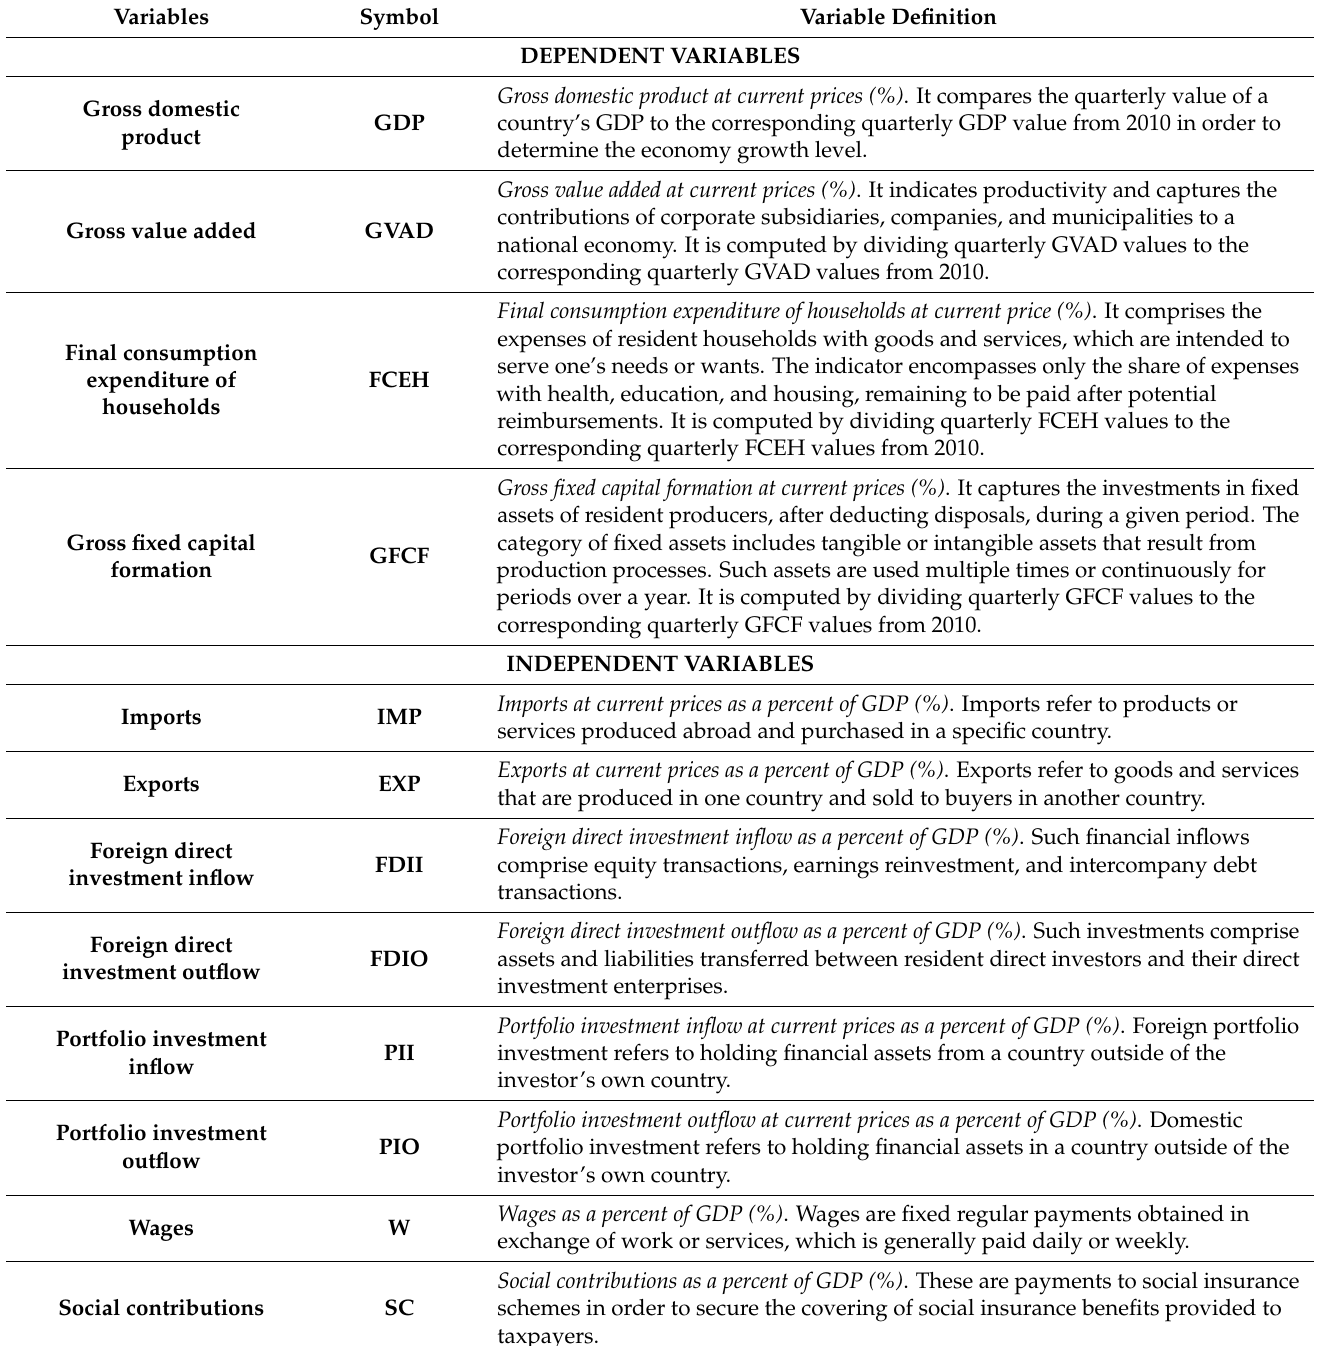
Table 1. Description of variables with definitions and